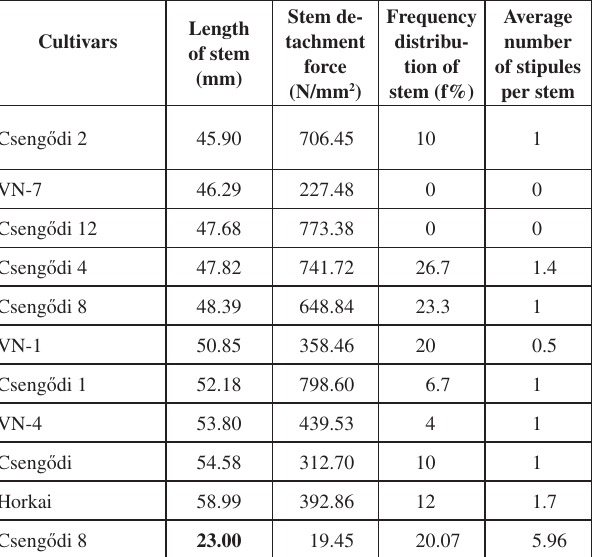
Table 2. Characteristic of stems of resistant sour cherry clones (Pallag-Debrecen, 2014)